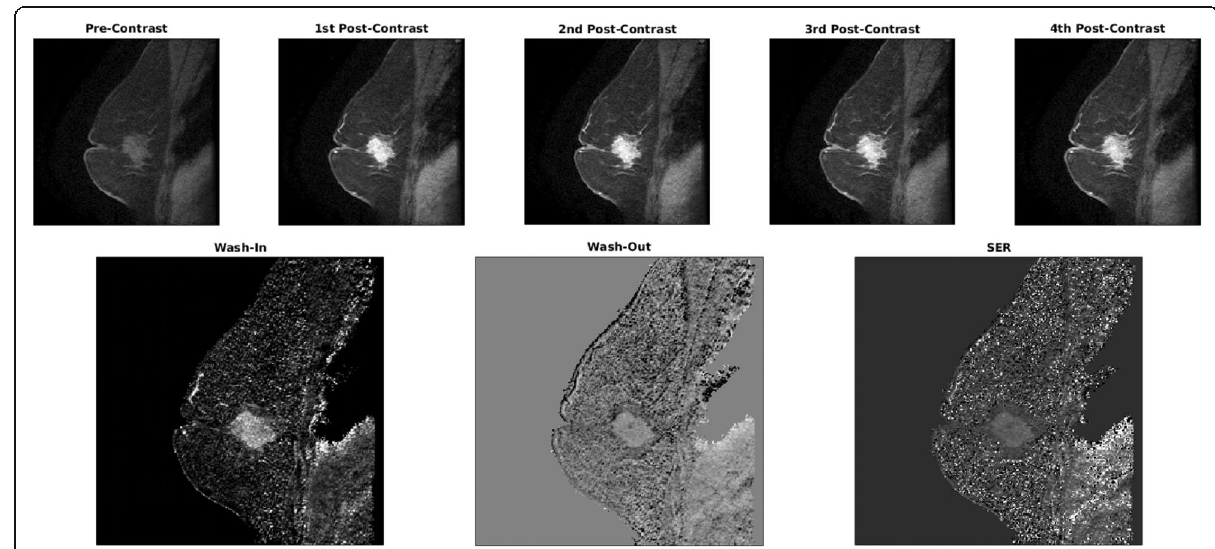
Fig. 2 Representative image of pre- and post-contrast images of an in-breast tumor and the calculated Wash-In, Wash-Out, and SER maps. Equations for map calculation: Wash-in map ((S 1 -S 0 )/S 0 ) × 100%, Wash-out map ((S 1 -S 4 )/S 1 )) × 100%, SER map ((S 1 -S 0 )/(S 4 -S 0 )) × 100%, where S 0 , S 1 , and S 4 are the pre-contrast, first postcontrast, and fourth (the last) post-contrast images,